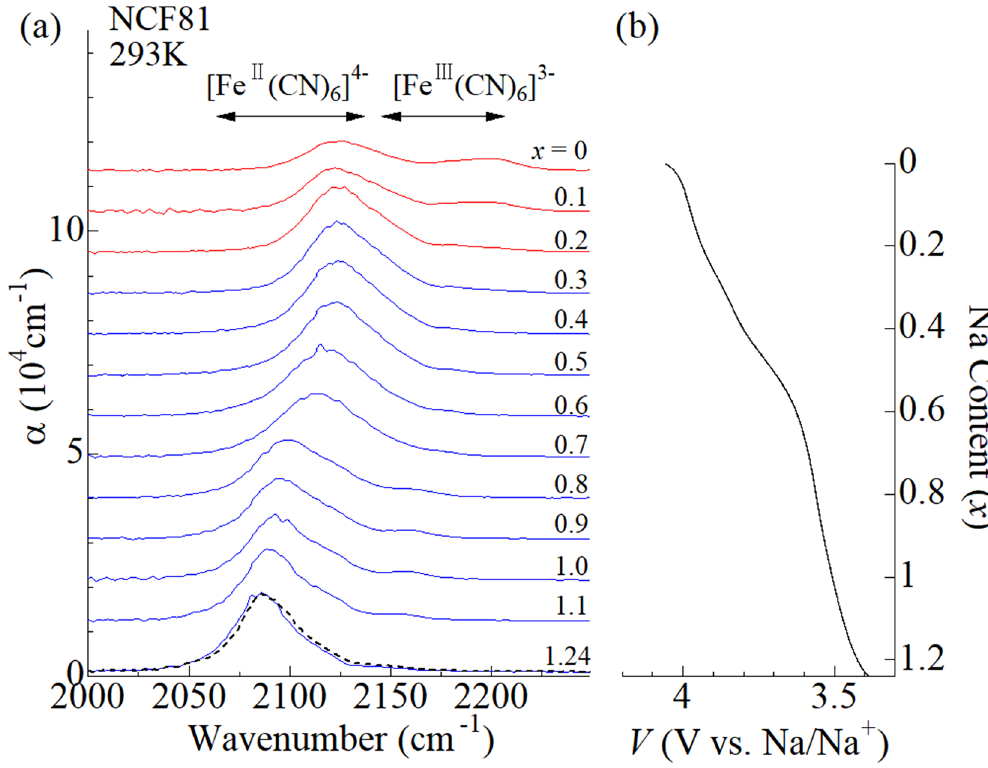
Figure 4. (a) In situ IR spectra of the NCF81 film at 293 K against x in the oxidation process from x = 1.24 to x = 0. Black broken curve at x = 1.24 was obtained after the measurement. α is absorption coefficient; α = where d is the film thickness, I 0 is the incident beam intensity, and I is the transmitted beam intensity, respectively. Spectra are vertically shifted for clarity. The horizontal arrows indicate the empirical region for the CN - stretching modes in [Fe II (CN) 6 ] 4- and [Fe III (CN) 6 ] 3- , respectively. (b) Charge curve of the NCF81 film measured at 293 K against x at 2.0 C. The voltages of the electrochemical cell were scaled to vs. Na/Na +